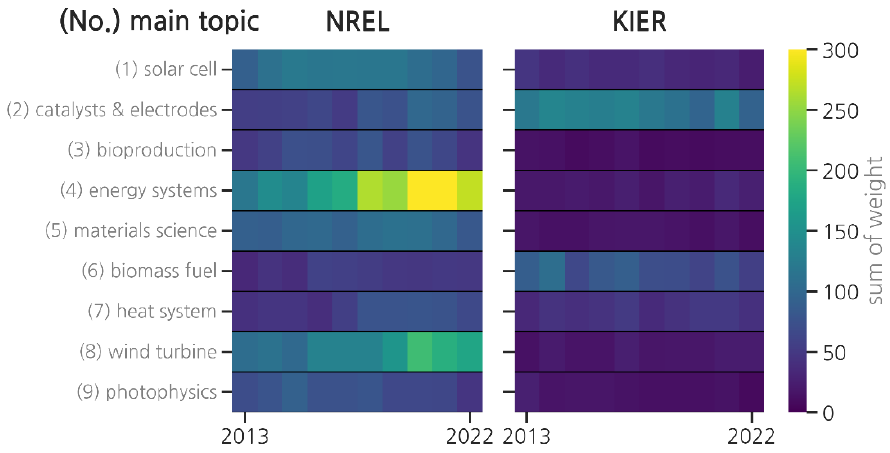
Figure 9. Weight summation as a function of time for nine topics as a function of time, with comparisons between the two institutions.